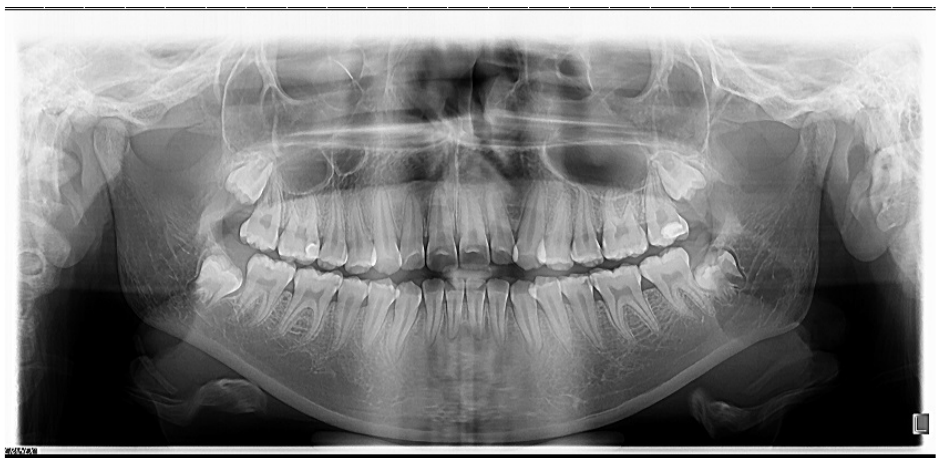
Figure 2. Initial orthopantomography.